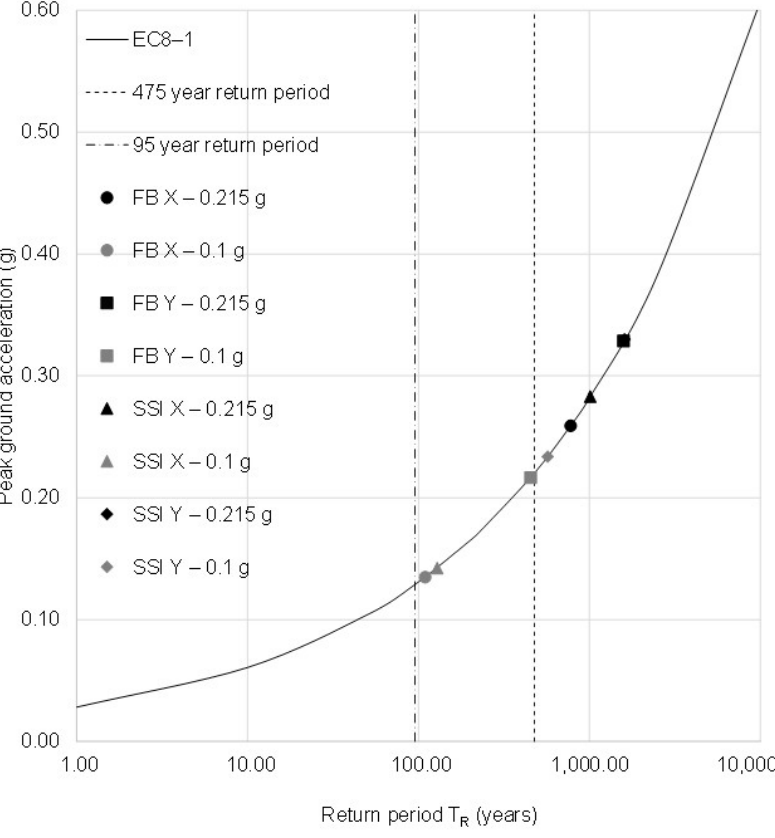
Figure 15. Return periods for all cases according to the N2 method shown on a logarithmic scale.